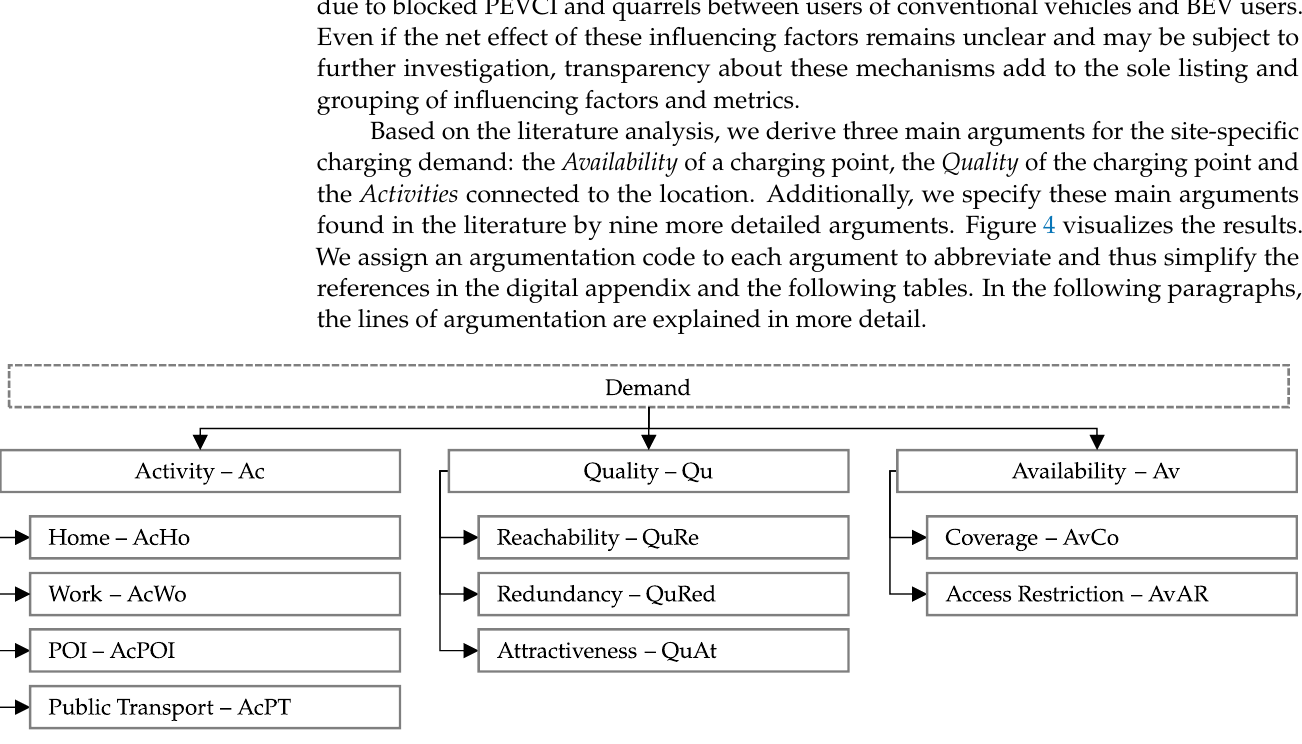
Figure 4. Lines of argumentation for the influencing factor’s effect on charging